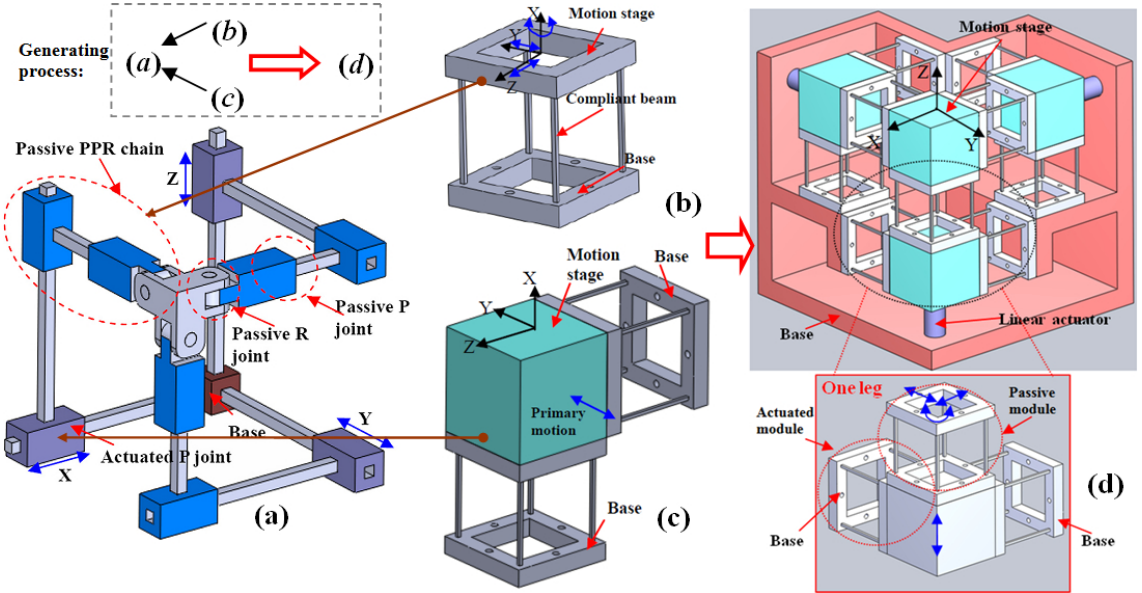
Figure 1. The generating process of a decoupled XYZ CPM: (a) A decoupled 3-PPPR XYZ PKM (Hao, 2011; Hao and Kong, 2012b) with three planes associated with the passive PPR kinematic chains orthogonal; (b) A compliant planar-motion PPR joint (Hao, 2011; Hao et al., 2011; Hao and Kong, 2013): spatial four-beam module that is composed four identical symmetrical square wire beams spaced around a circle uniformly; (c) A compliant P joint (Hao, 2011; Hao and Kong, 2012b): two spatial four-beam modules connected in parallel, two planes associated two PPR joints of which are orthogonal; (d) A decoupled XYZ CPM using identical spatial four-beam